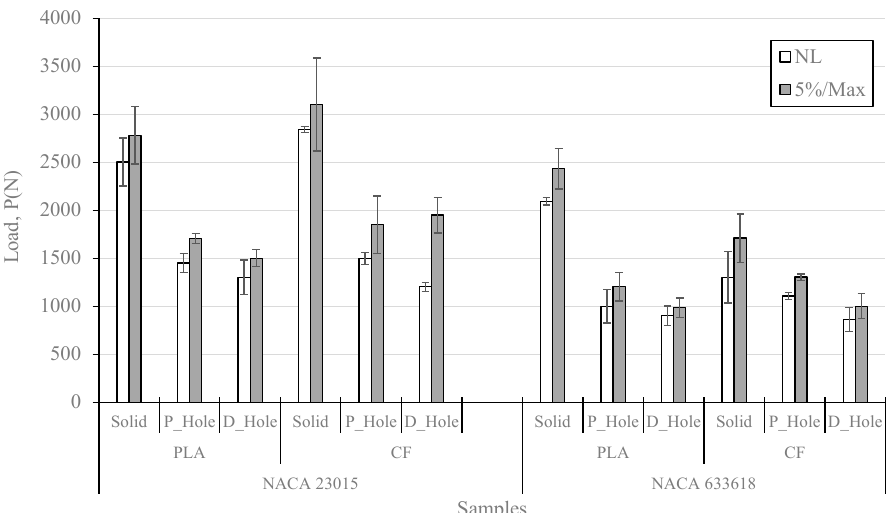
Figure 7. Comparison of maximum compression loading values, C.I. 95%.